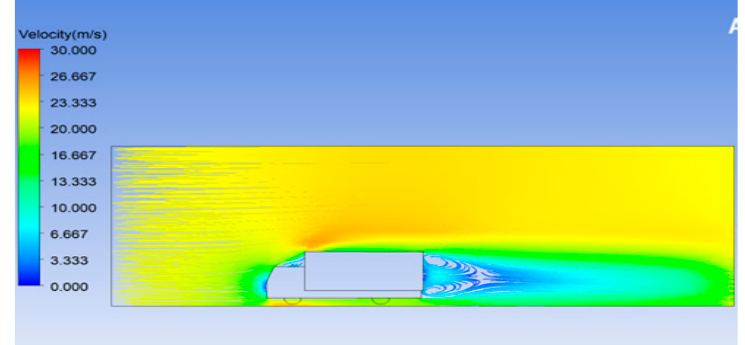
Figure 5. The result of CFD analysis.